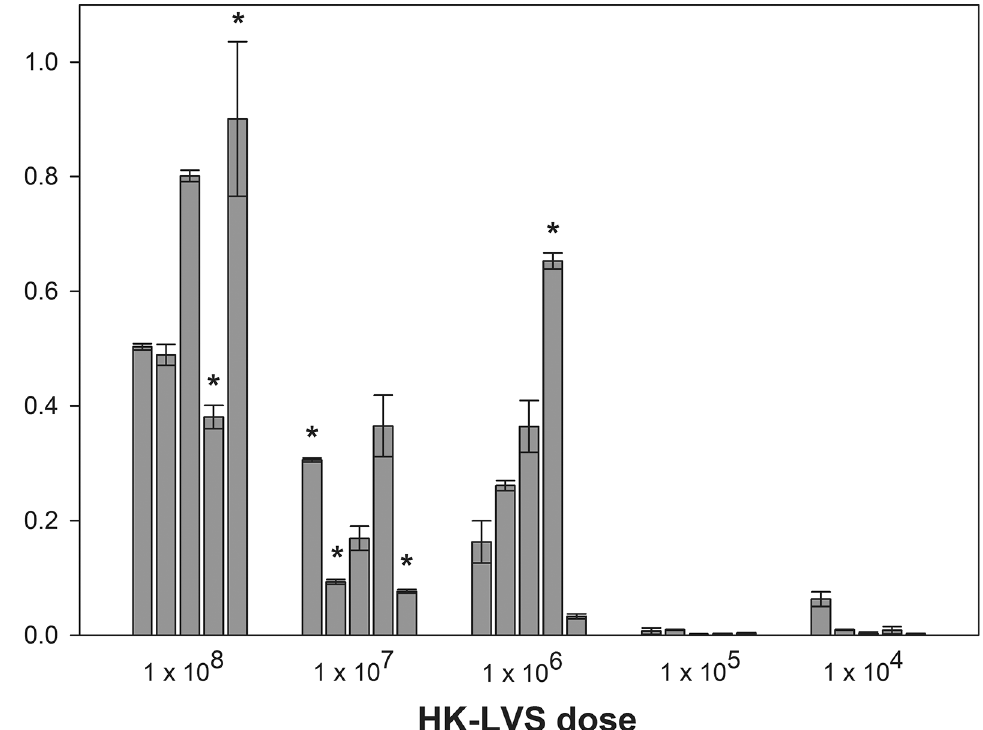
Fig 5. Anti-LVS antibody titers of HK-LVS vaccinated BALB/cByJ mice do not correlate with survival. Sera from BALB/cByJ mice vaccinated with different doses of HK-LVS were individually analyzed six weeks after vaccination for anti-LVS total IgG. Mice were then challenged IP with a maximal lethal dose of LVS. Error bars depict standard deviation of the mean of triplicates samples tested in the ELISA. * indicates the antibody responses of the mice that eventually survived the lethal challenge. Results shown are from one representative experiment of two independent experiments of similar design and outcome.